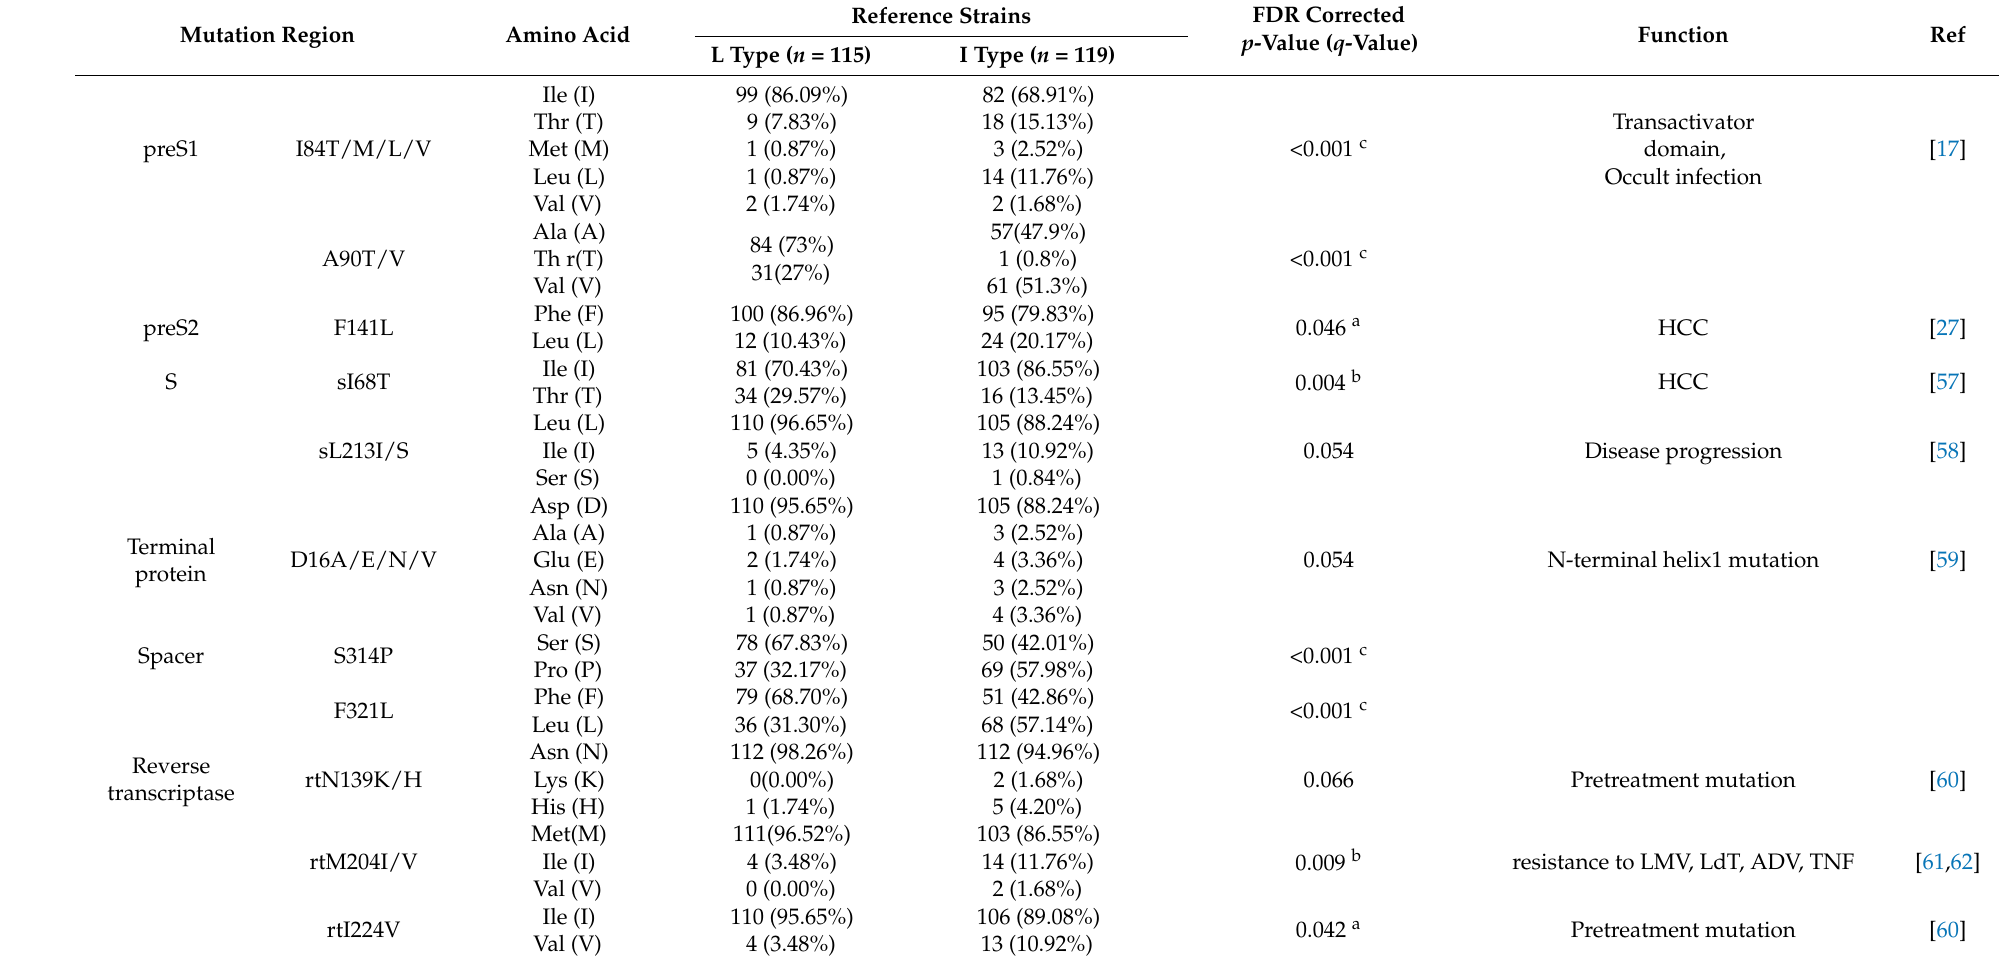
Table 3. Comparison of the signature nonsynonymous mutation rate between rt269L and